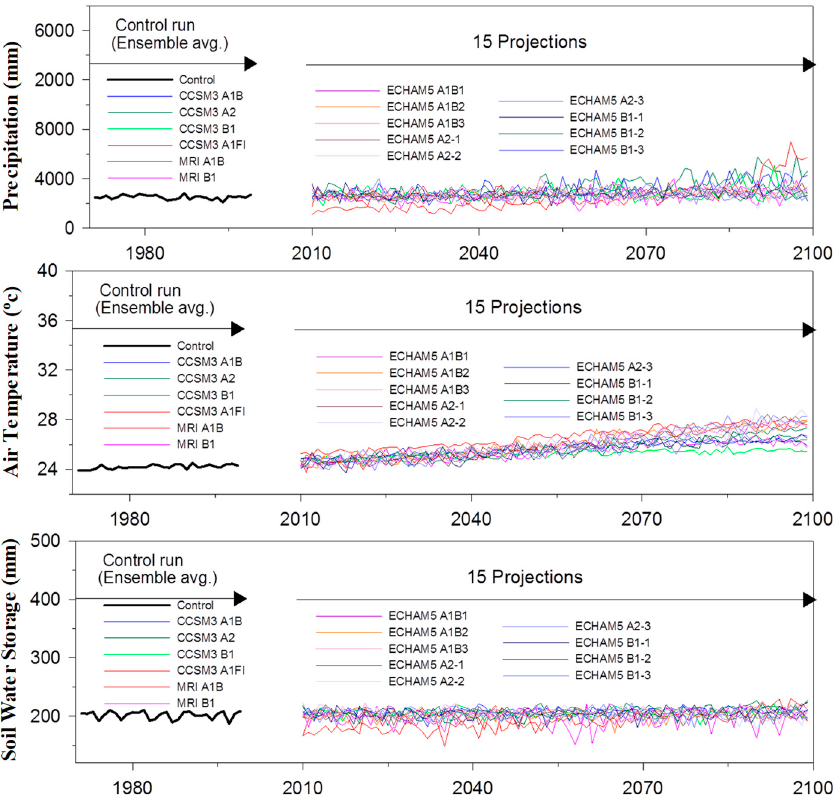
Figure 5. Basin-average annual precipitation, air temperature, and soil water storage during the historical period (1970–2000) and during each of the projected future (2010–2100) conditions in Kelantan